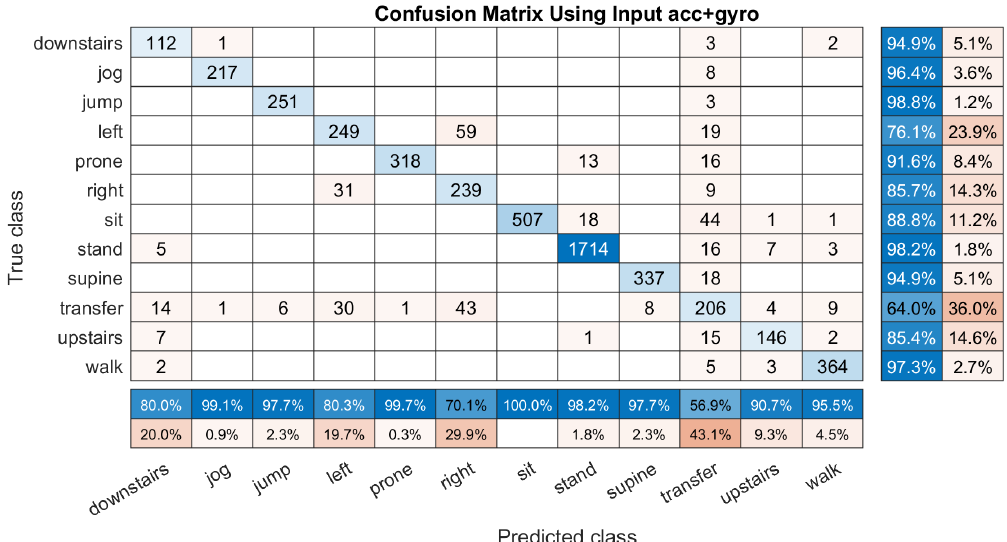
Figure 7. An example of the confusion matrix computed based on the input ’acc+gyro’ (˜ s ∗ = { s α , s β } ). It have a column summary and row summary to display the accuracy and the errors of each activity.